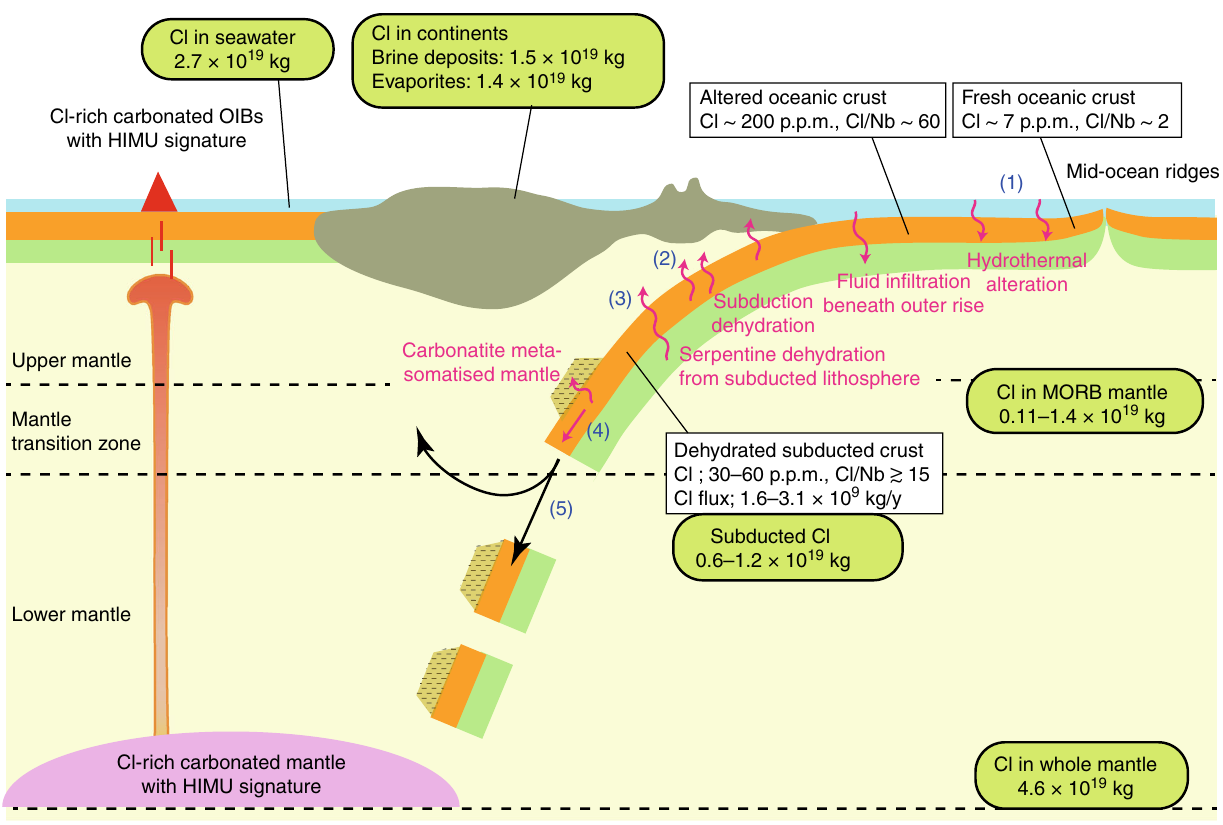
Fig. 4 Schematic illustration of Cl behaviour during subduction and Cl inventory. White boxes show Cl concentration and fl ux in transporting media from the surface to the mantle. Green ovals show the Cl inventory in major Cl reservoirs (Supplementary Table 4). Chlorine is transferred by subducted